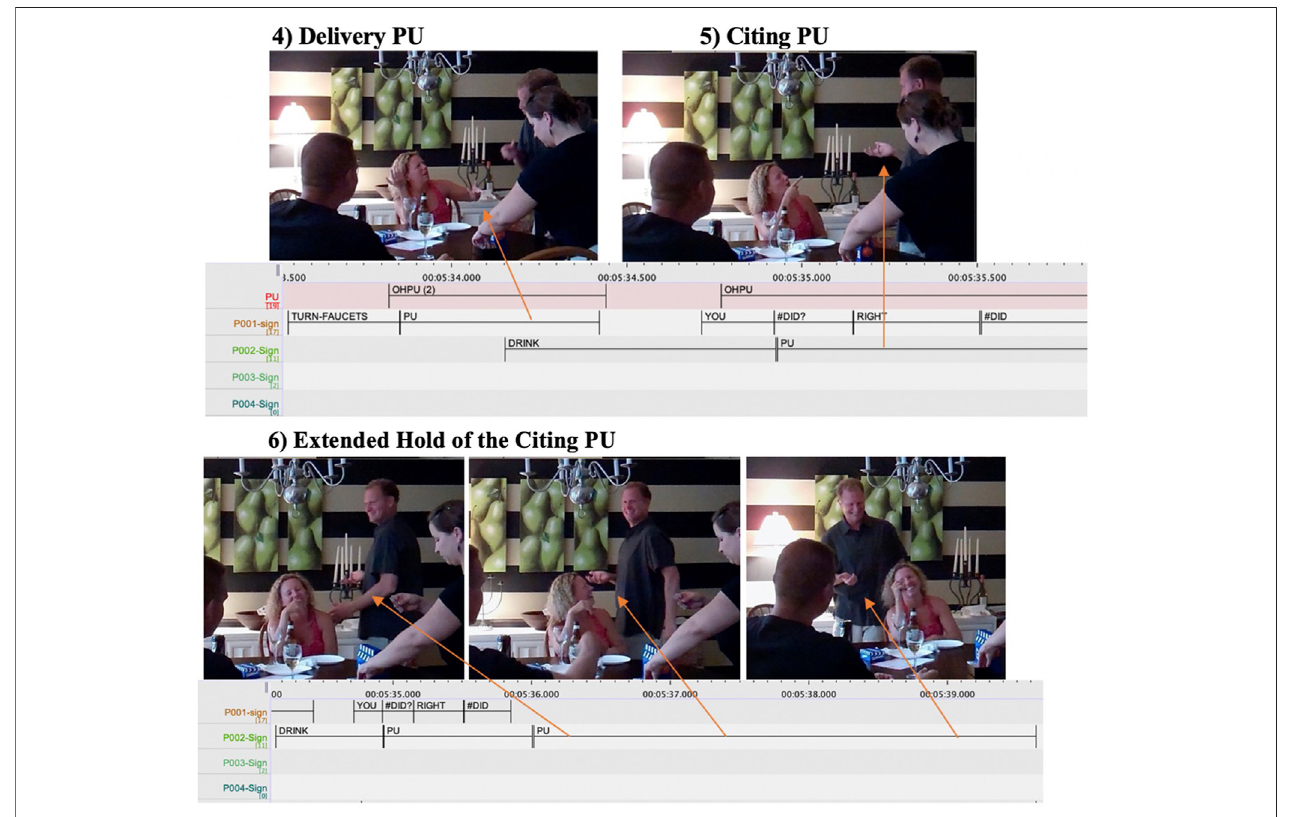
FIGURE 9 | Delivery and citing PU in